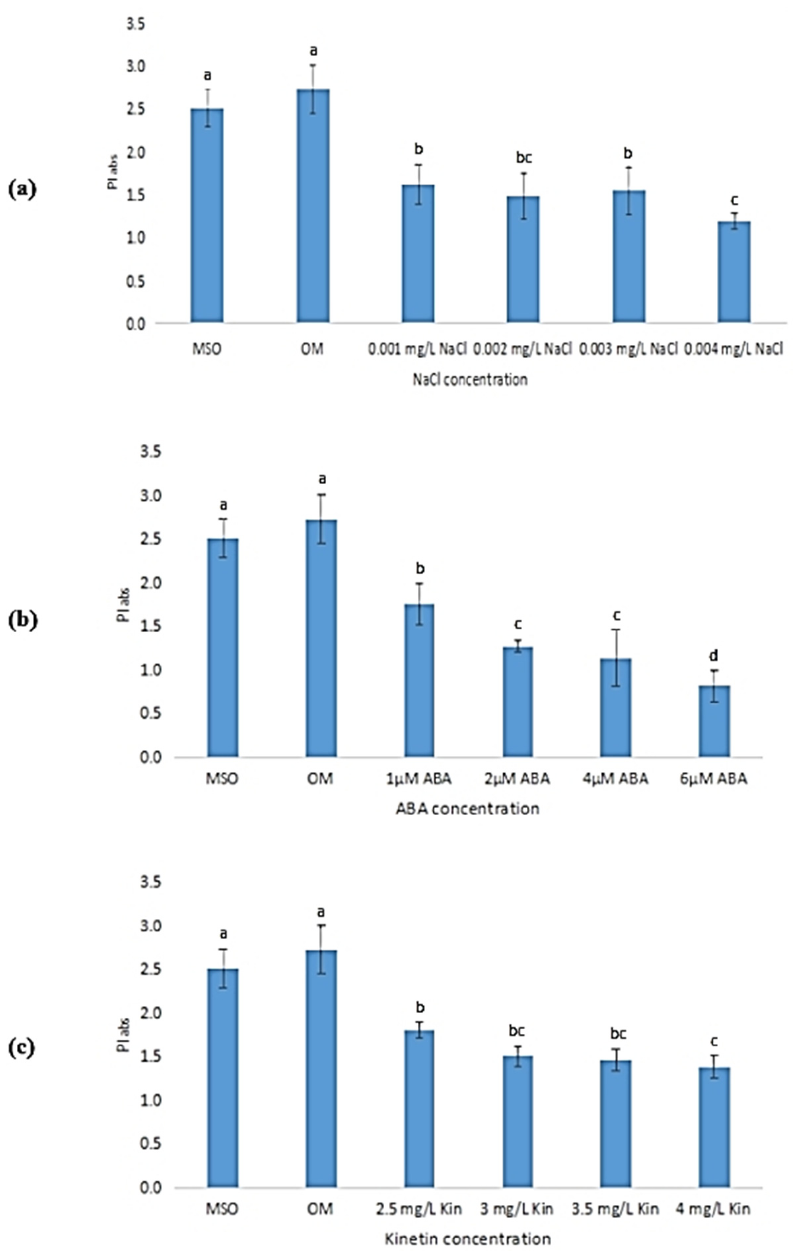
Figure 17. Performance index (PI) of plants exposed to: ( a ) salt stress; ( b ) ABA; ( c ) high kinetin levels. Means with different letters are significantly different at p < 0.05 according to Duncan’s multiple range test (DMRT).